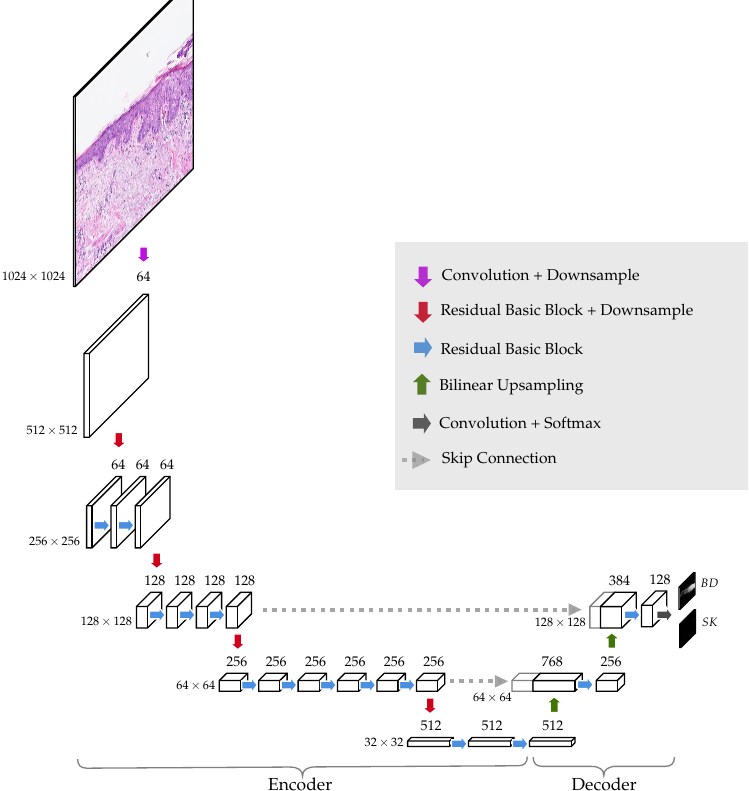
Figure 4. The implemented U-Net-based neural network is composed of an encoder and a decoder. By means of the encoder, the spatial dimension of the WSIs are convoluted and reduced from 1024px × 1024px to 32px × 32px. This part of the network acts as a feature extractor. Information not relevant for the diagnosis is also discarded due to the bottleneck effect occurring in the middle of the network. The extracted features then pass through a series of convolution and bilinear upsampling operations in the decoder to finally create two probability heat maps of size 128px × 128px (one corresponding to BD and the other to SK). Each pixel in the output corresponds to a 8px × 8px region of the input